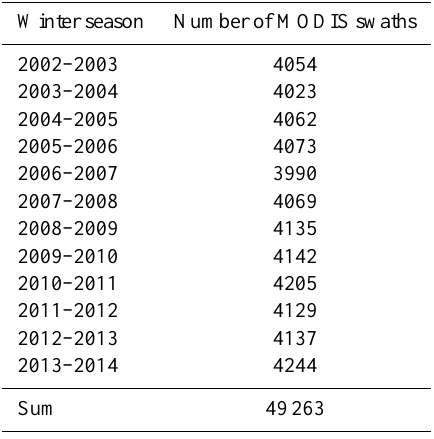
Table 1. Total number of individual MODIS swaths, which were incorporated into the thin-ice thickness (TIT) calculations. Numbers are given for each winter season from November to